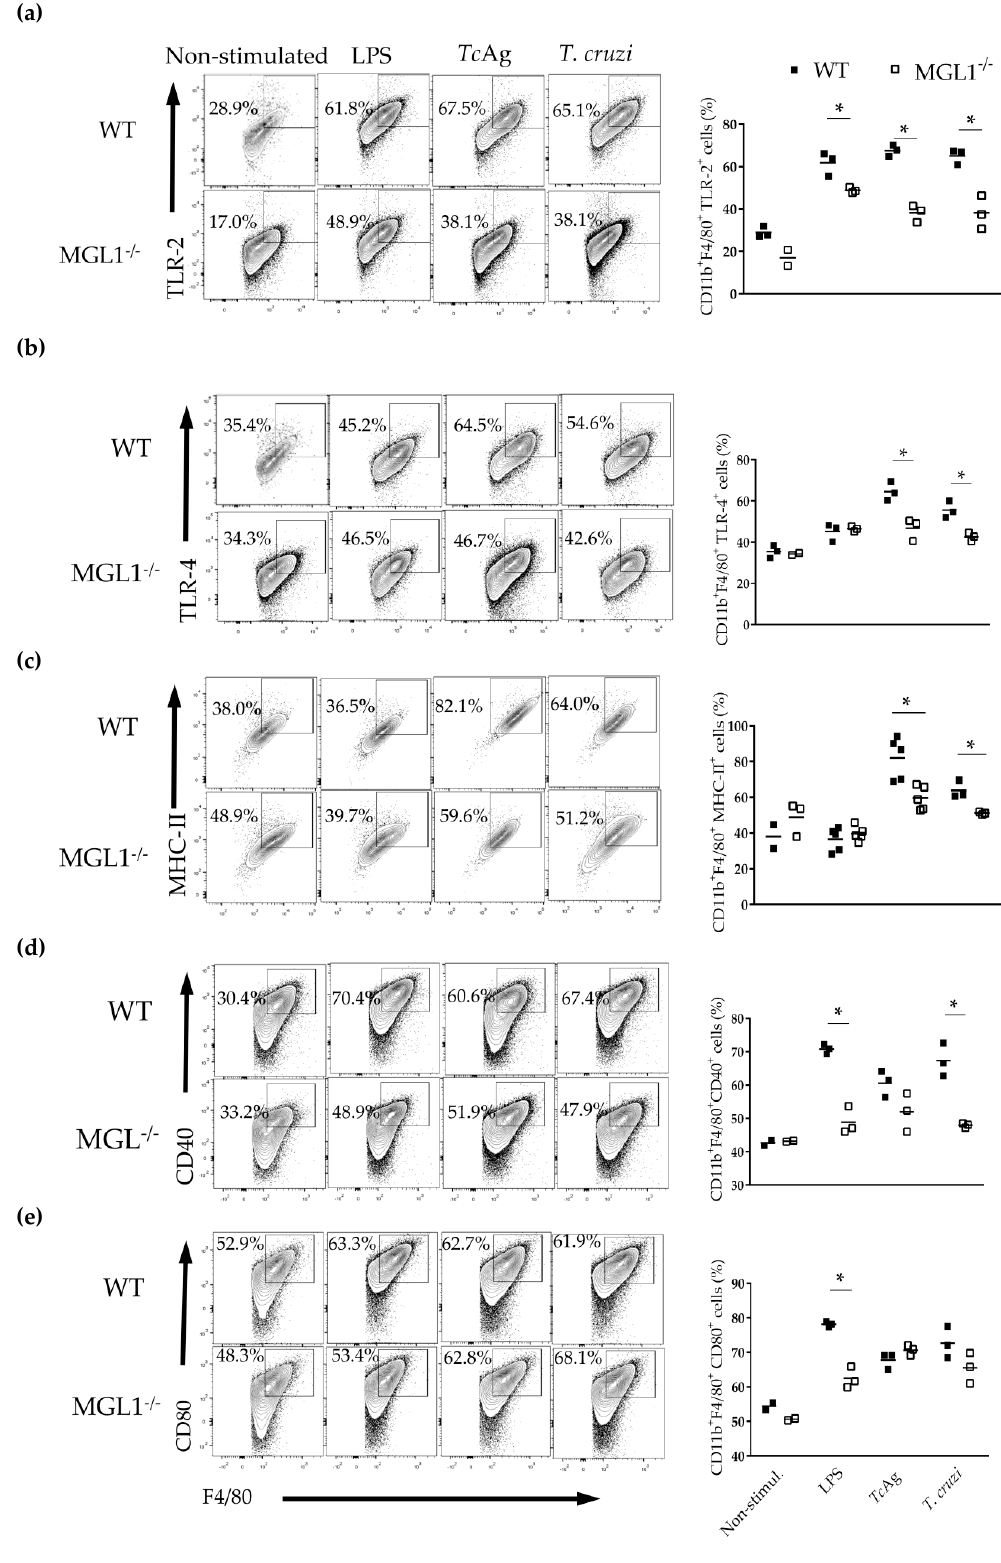
Figure 4. The absence of MGL1 results in reduced expression of TLR2, TLR4, MHCII and CD40 in PE-M φ . ( a – e ) PE-M φ from WT and MGL1 − / − mice were stimulated in vitro with LPS (100 ng/mL) or Tc Ag (25 µg/mL) or infected with epimastigotes of T. cruzi (ratio 1:10) for 24 h. The cells were stained with anti-F4 / 80, anti-TLR-2, anti-TLR-4, anti-MHC-II, anti-CD80 and anti-CD40. The dot plot and bar charts are representative of three independent experiments; * p <